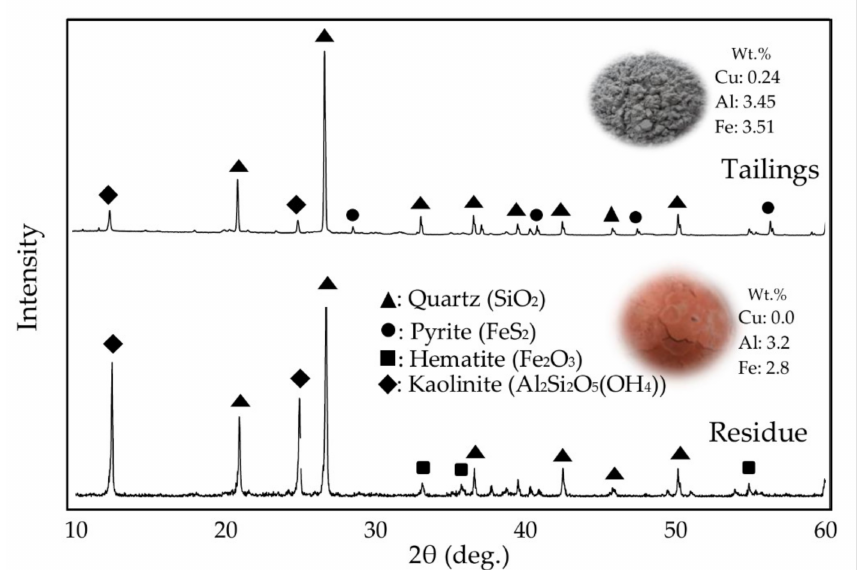
Figure 6. XRD patterns of the residue obtained after leaching of mine tailings with distilled water and the mine